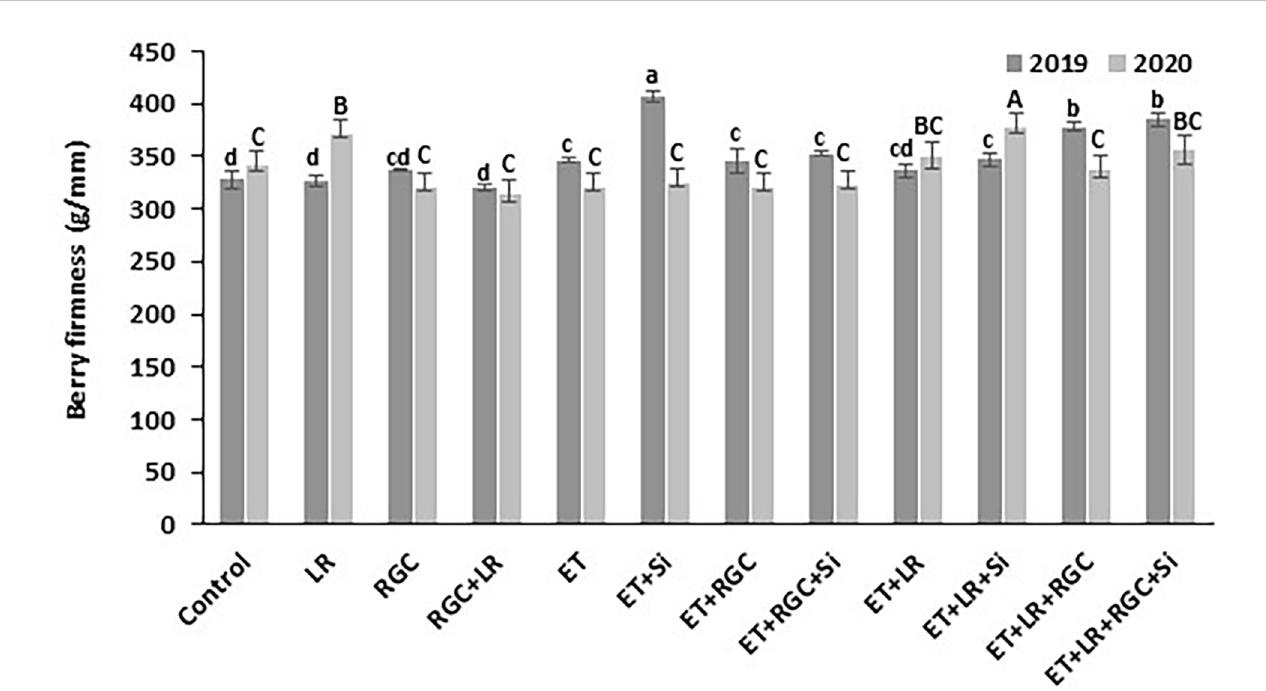
FIGURE 6 Berry fi rmness as affected by the different treatments. Treatments were: ethephon (ET), silicon 7% (Si), light-re fl ective ground cover (RGC), and their combinations. Treatments have been conducted with or without cluster-zone leaf removal (LR). The effects of Si is not reported in the fi gure. Values are the mean of four readings, and the error bars represent the standard deviation. Different letters on bars indicate signi fi cant differences within the same year at p < 0.05 according to the Tukey HSD test within the same season.